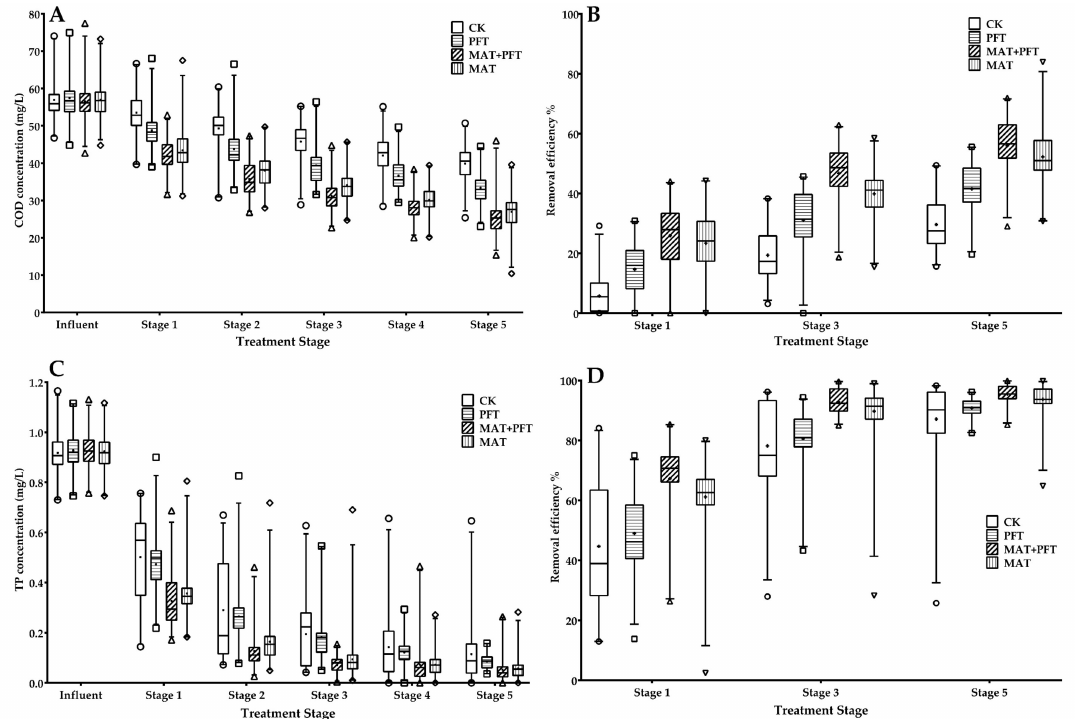
Figure 6. Changes of COD ( A ) and TP concentrations ( C ), as well as removal efficiencies of COD ( B ) and TP ( D ) in the PSCW. CK, PFT, MAT, and MAT with PFT represent the control and PSCW treatments with polyethylene fiber, M . aquaticum , and M . aquaticum with polyethylene fiber, respectively. Black solid lines and plus signs represent the median and mean of the datasets, respectively. The bottom and top edges of the box plots indicate the 25th and 75th percentiles, and the whiskers illustrate the 2.5th and 97.5th